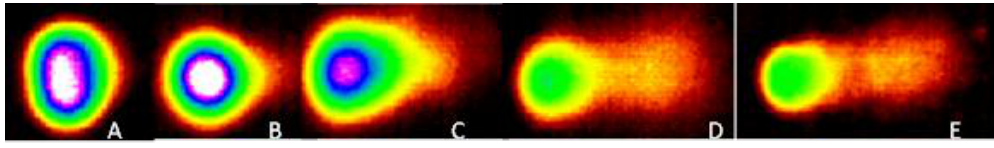
Figure 3. Representative microphotographs of Comets indicating changes in DNA content based on increasing ATO concentration after 24 h exposure. ( A ) 0, ( B ) 1, ( C ) 3, ( D ) 5, and ( E ) (7 μg/mL ATO) represent damaged DNA , results showed increased damage as indicative of the increase in tail